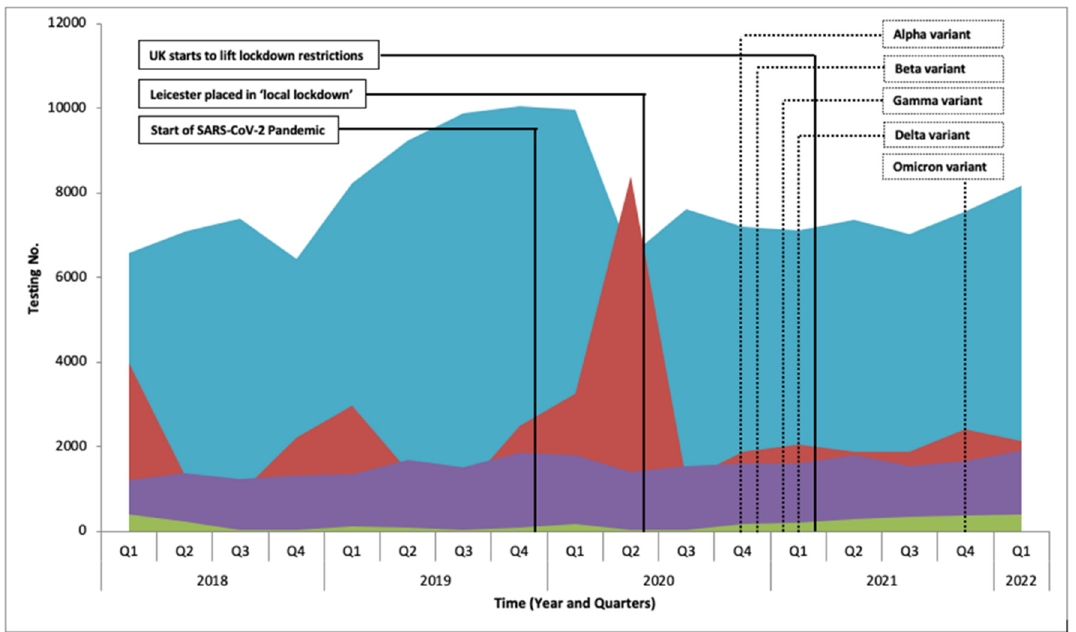
Figure 1. Routine Viral Screening (excluding SARS-CoV-2). Viruses are grouped into four groups; blood borne viruses (blue), respiratory viruses (red), herpes viruses (purple), diarrhoeal viruses